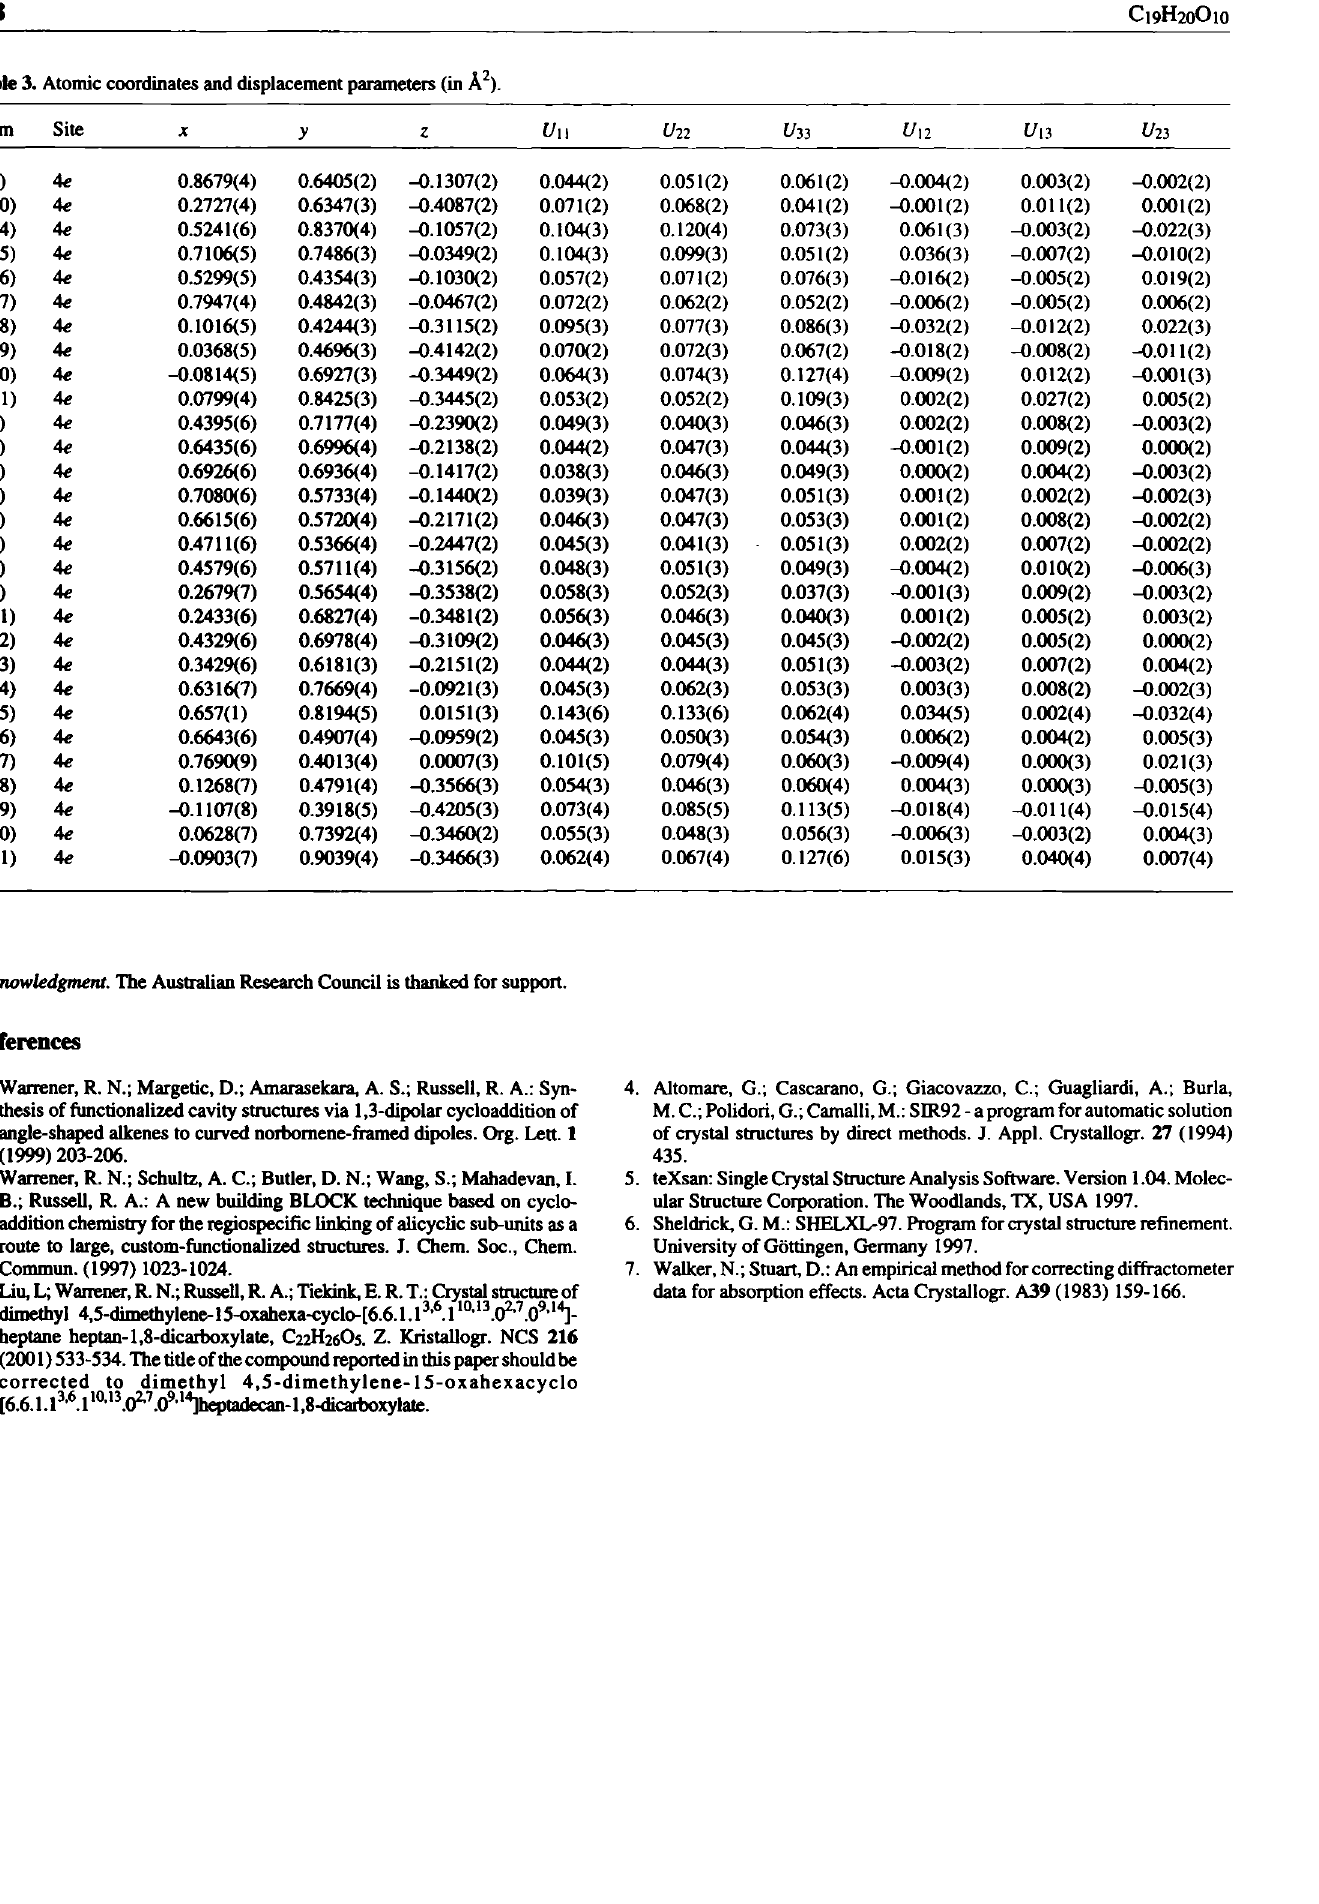
Table 3. Atomic coordinates and displacement parameters (in Â 2